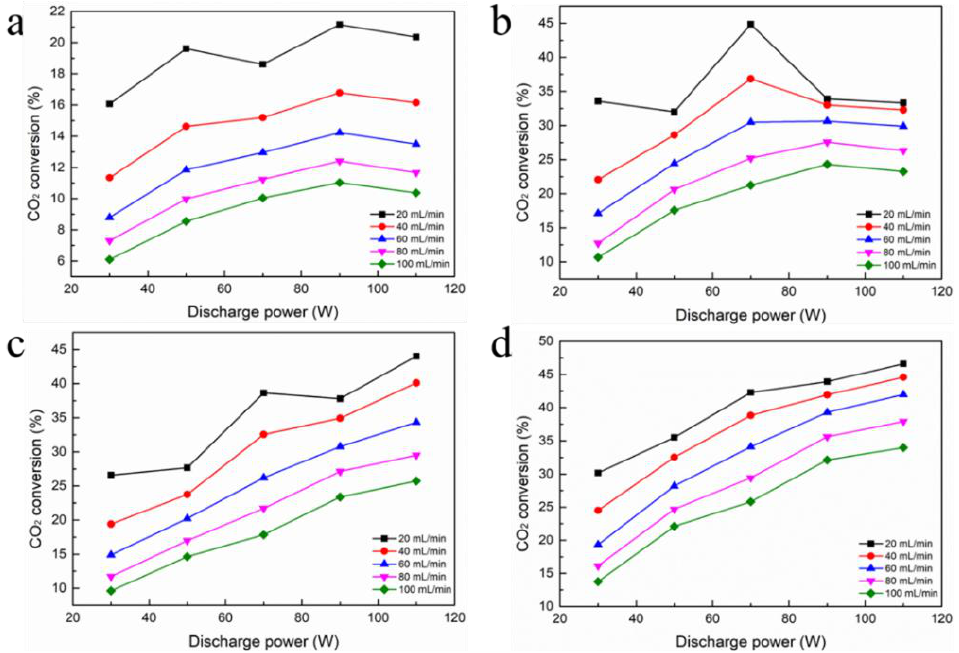
Figure 6. Effect of discharge power and gas flow velocity on CO 2 conversion: ( a ) Without packing; ( b ) Foam Fe; ( c ) Foam Al; ( d ) Foam Ti.